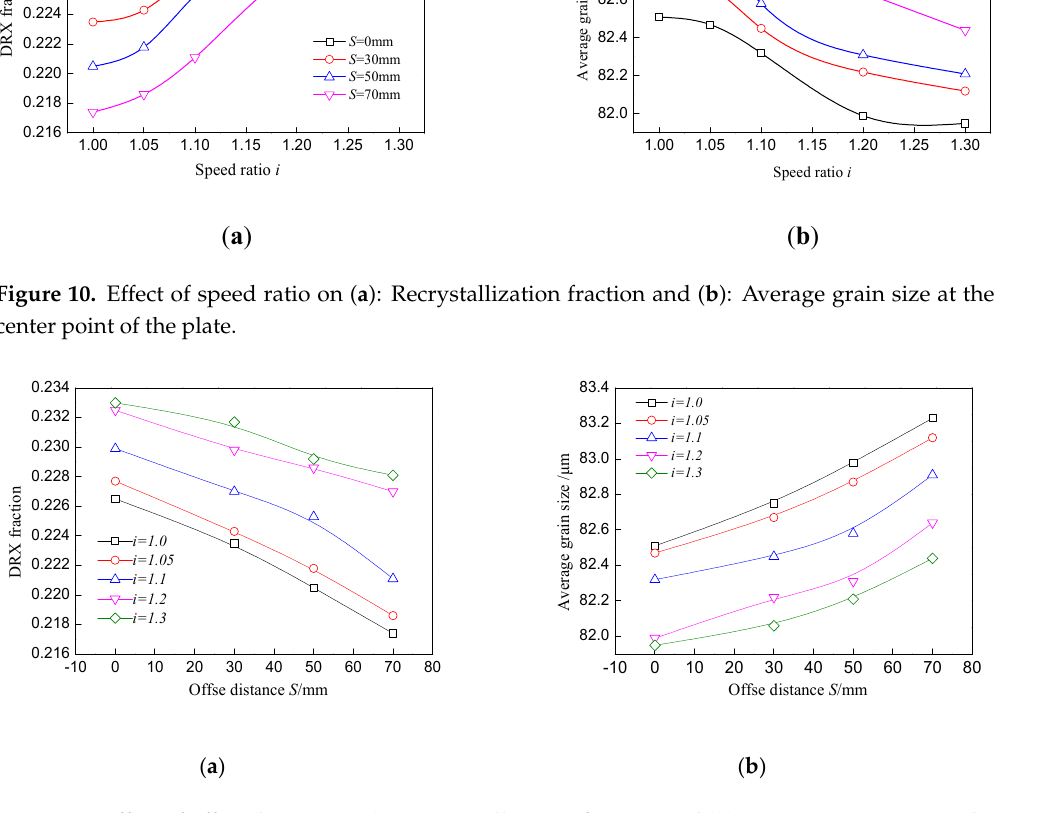
Figure 11. Effect of offset distance on ( a ): Recrystallization fraction and ( b ): Average grain size at the center point of the plate.